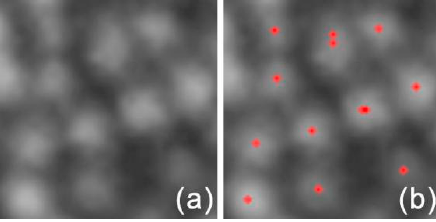
Figure 5. Cone cell identification based on K -means clustering. ( a ) Denoised AO-SLO image patch. ( b ) Identified cone cells marked in red on denoised AO-SLO image patch. ( b ) Identified cone cells marked in red on denoised AO-SLO image